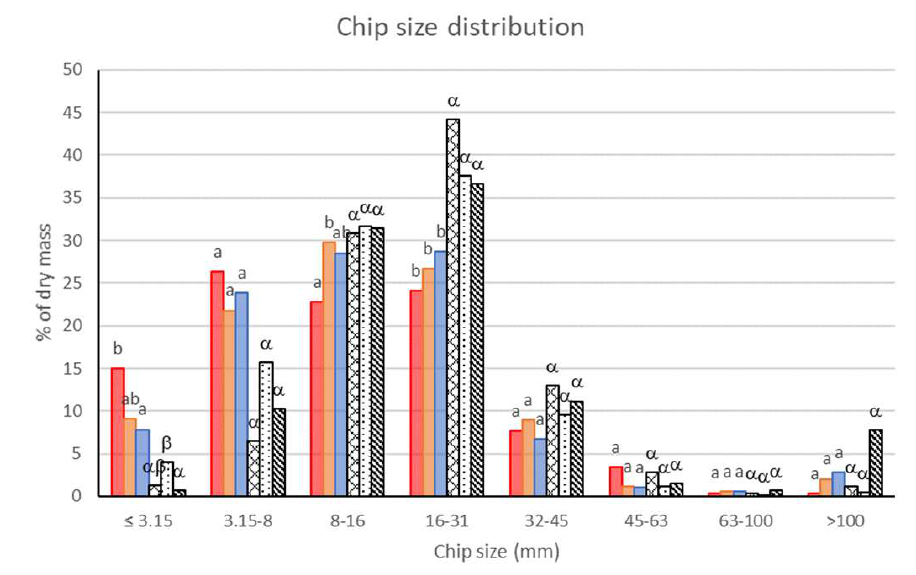
Figure 1. Particle size distribution for unsieved and sieved woodchips from the three study sites. Coloured bars beneath different Roman letters indicate a significant difference in the material as delivered between study sites. Different Greek letters centred in the patterned bars indicate a significant difference in the sieved material between study sites. Block 1 is represented by red and cross-hatched bars, block 2 by orange and dotted bars and block 3 by blue and diagonally striped bars. The chips were produced with a chipper and then screened into different qualities using Backers star screens (Backers, Twist, Germany) in block 1 and block 3 and a Maskin Mekano Lv 302 T3 vibrating screen (Maskin Mekano, Jönköping, Sweden) in block 2. Fines were separated using sieving decks that separated 8 mm grain size in block 3 and 8 mm and 10 mm in block 1. In block 2, a 15 × 15 mm mesh size screen was used. The sieving operation took place on the same days as the establishment of the storage trials; sieving performance is described in [31]. The sieving operation reduced the variations in chip size distribution, and significant differences between study sites could only be found for